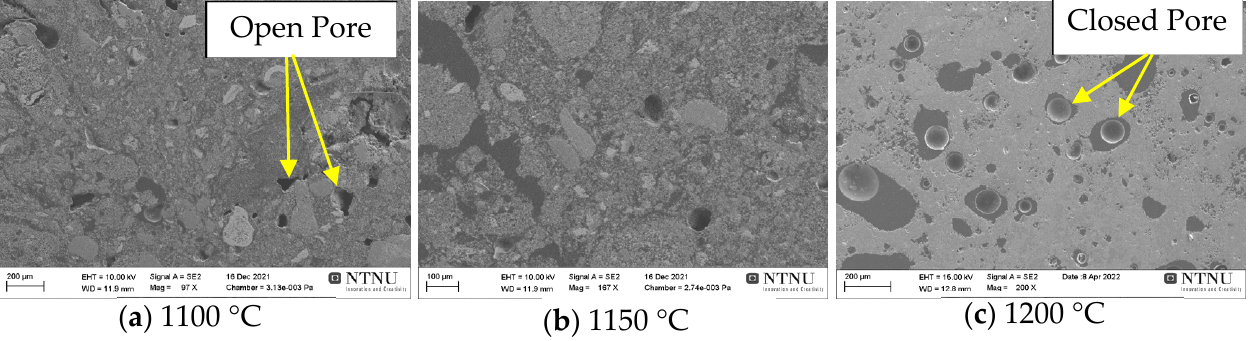
Figure 8. SEM secondary electron image of C 1 A ratio pellets with three different sintering tempera- tures ( a ) 1100 °C, ( b ) 1150 °C, ( c ) 1200 °C.